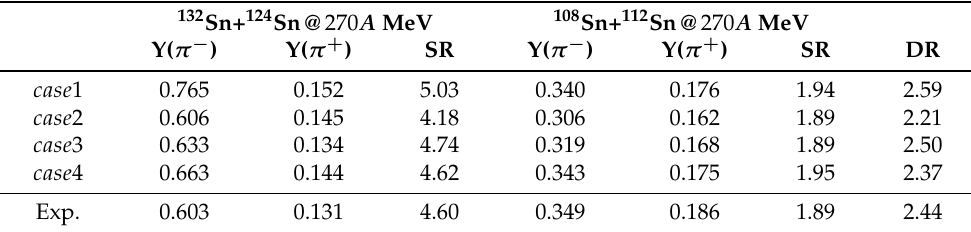
Table 4. Pion multiplicities Y( π ± ), single multiplicity ratio SR( π − / π + ), and double multiplicity ratio DR( π − / π + ) of Sn+Sn collisions for the four cases. The experimental data of Sn+Sn collisions are from the S π RIT Experiment